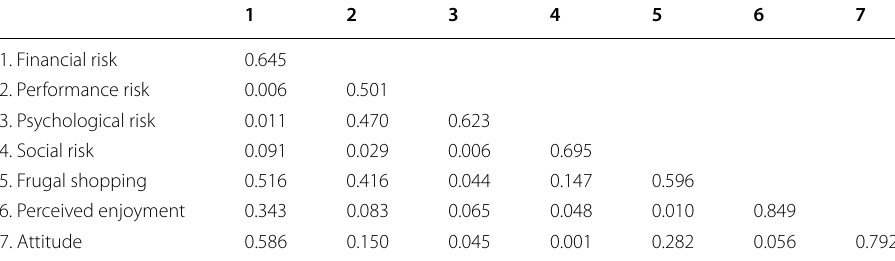
The numbers below diagonal are the squared correlation coefficient between the variables. The numbers in diagonal are the average variance extracted by each variable